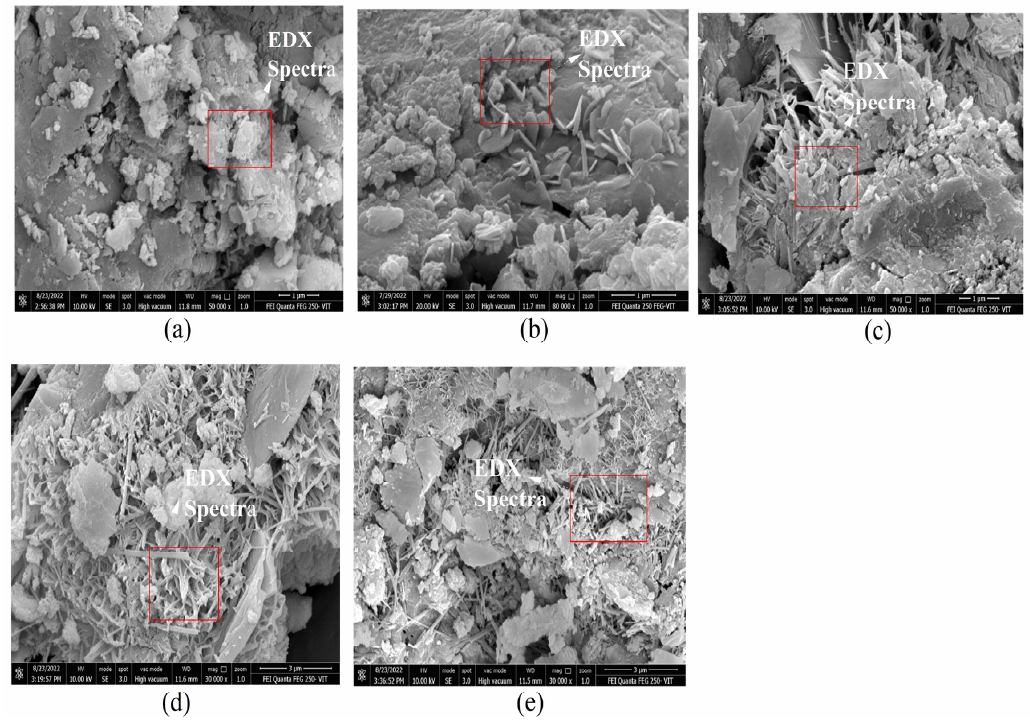
Figure 7. SEM of CM-UFS-GO composites. ( a ) CM1; ( b ) CM2; ( c ) CM3; ( d ) CM4; and ( e ) CM5.